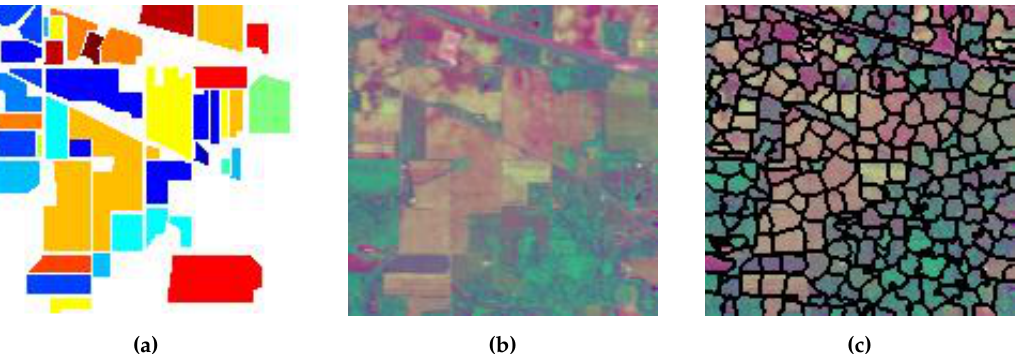
Figure 3. The superpixel generation process of the Indian Pine dataset. ( a ) the ground truth, ( b ) the first three components of the HSI data, ( c ) the produced superpixel map.